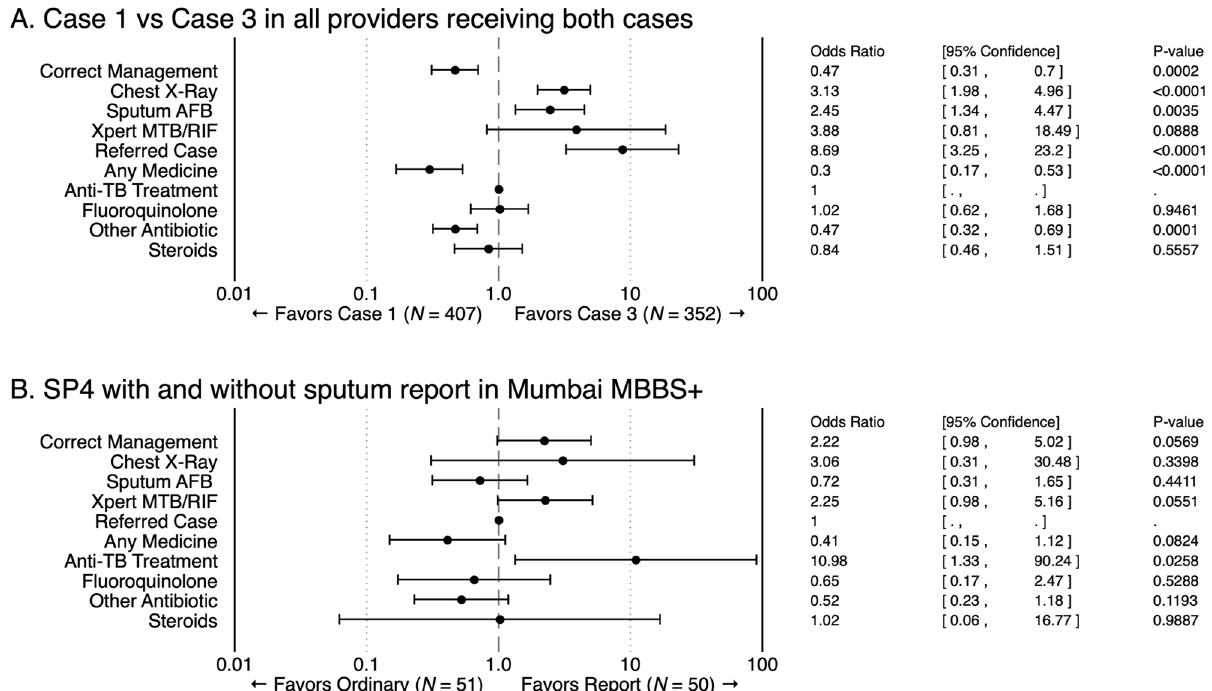
Fig 4. Quality of care differences between SP case scenarios. Estimated ORs between specific case scenarios for the frequency with which the indicated management action is observed. Panel A reports estimated ORs between Case 1 and Case 3, including only those providers who received both cases ( N = 759 interactions). Panel B reports estimated ORs between Mumbai MBBS providers who received the experimental version of Case 4 that carried the same sputum report against a comparable sample who received the ordinary Case 4 presentation (as described in S1 Text; N = 101 interactions). AFB, acid-fast bacillus; MBBS, Bachelor of Medicine, Bachelor of Surgery; OR, odds ratio; SP, standardized patient; TB, tuberculosis; Xpert MTB/RIF, Xpert Mycobacterium tuberculosis/Rifampicin, also known as GeneXpert.